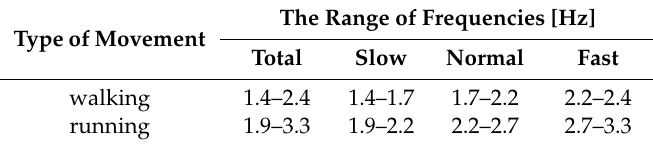
Table 3. Typical pacing frequencies for walking and running [25].